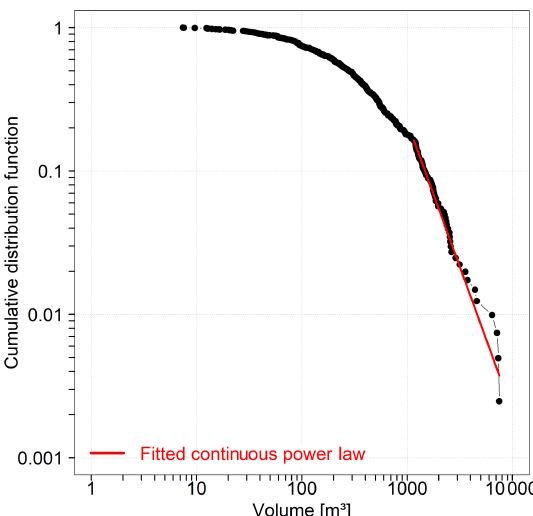
Figure 8. Magnitude–frequency relationship displayed with a cu- mulative distribution function for the debris flows in GT, LT and ZT. The fitted continuous power law describes the relationship for debris flows with a volume greater than 1025m 3